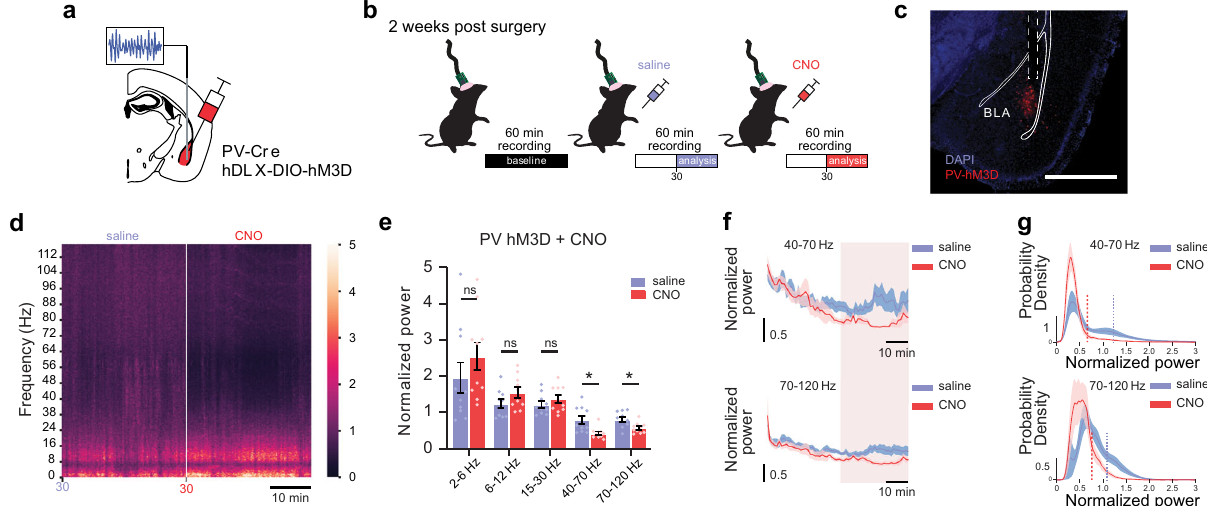
Fig. 6 Gq signaling in BLA PV interneurons recon fi gures BLA oscillatory activity in vivo. a Schematic illustrating hDLX-DIO-hM3D-mCherry injection and LFP recording strategy in the BLA of PV-Cre mice. b Experimental timeline for LFP recordings before (baseline) and after IP injection of saline, followed by CNO. c Representative image illustrating hM3D-mCherry expression and LFP recording electrode placement in the BLA (dashed lines). Scale bar, 1 mm. d Average spectrogram illustrating normalized power (0 – 5: low-to-high power) across frequencies over the last 30 min of saline and CNO treatments. e Mean (±SEM) normalized power across treatments (CNO vs. saline) and frequency bands. Values from last 30 min of recording were used for analysis, illustrated by the highlighted sections in f . Two-way ANOVA [treatment × frequency], F(1.081, 9.728) = 4.024, p = 0.0714; Sidak ’ s multiple comparisons test: 2 – 6 Hz, p = 0.6152; 6 – 12 Hz, p = 0.4240; 15 – 30 Hz, p = 0.6838; 40 – 70 Hz, p = 0.0228; 70 – 120 Hz, p = 0.0120. n = 10 mice. * p < 0.05, ns not signi fi cant. f Normalized power across time for 40 – 70 Hz (top) and 70 – 120 Hz (bottom). Values averaged in 1-min bins. Blue/red lines = average power over time, blue/red-shaded areas = SEM. Highlighted region indicates last 30 min included in analysis. g Average probability density plots illustrating the distribution of gamma powers across treatments for 40 – 70 Hz (top) and 70 – 120 Hz (bottom). Blue/red solid lines = average probability, blue/red-shaded areas = SEM. Vertical lines indicate average threshold value for distribution tails, where threshold = 1 standard deviation above the mean. Paired t -test (two-tailed), saline vs. CNO 40 – 70 Hz distribution tail powers ( n = 10 mice, p = 0.0027); saline 2 vs. NE 70 – 120 Hz distribution tail powers ( n = 10 mice, p = 0.0005). Source data are provided as a Source Data fi